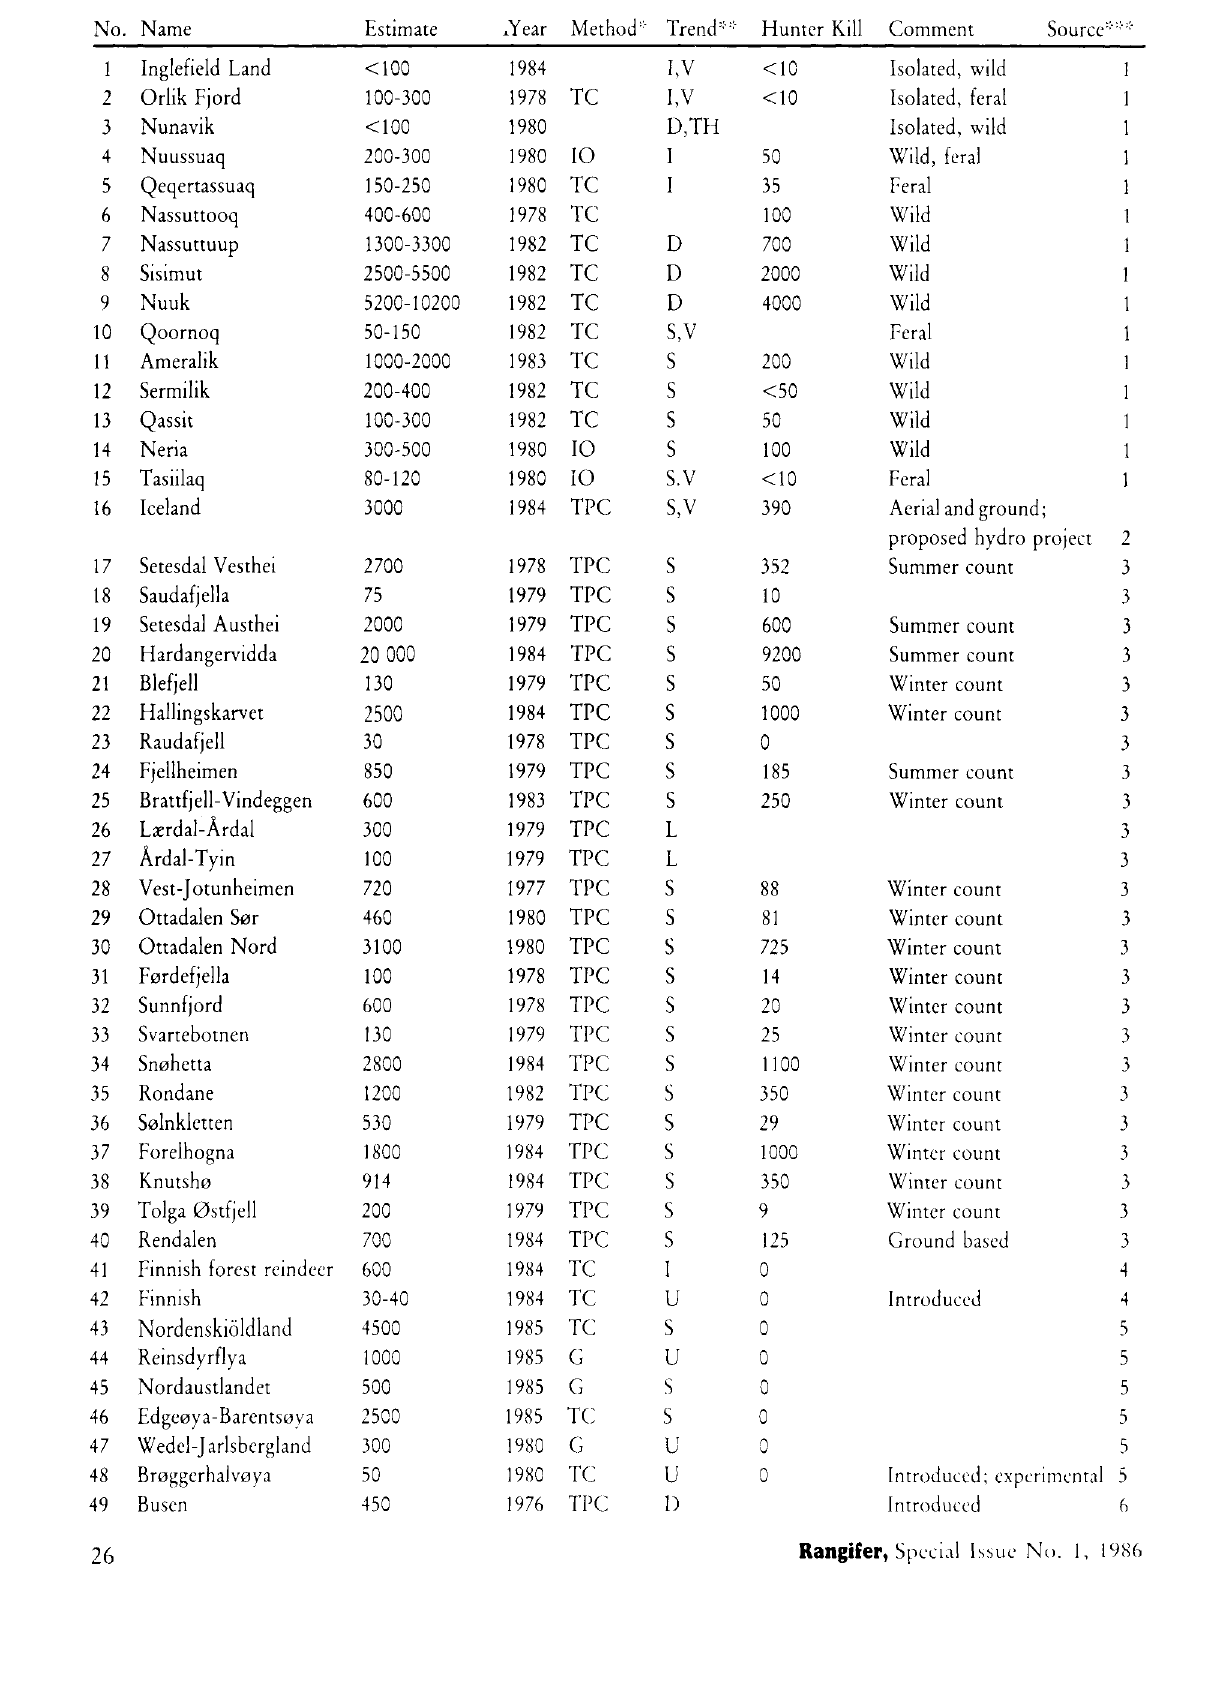
Table 2. Wild Rangifer tarandus herds in Europe, Asia and South